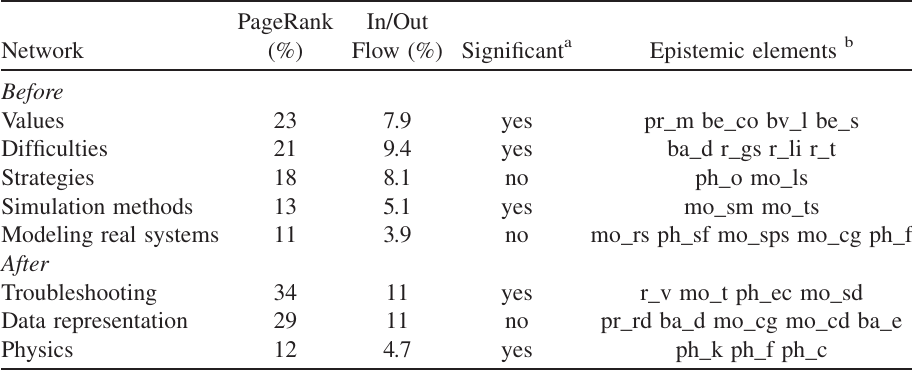
TABLE I. Clustering of selected number of epistemic element into the modules with the highest flow for each network. For a description of epistemic elements, see the Appendix, Table III.